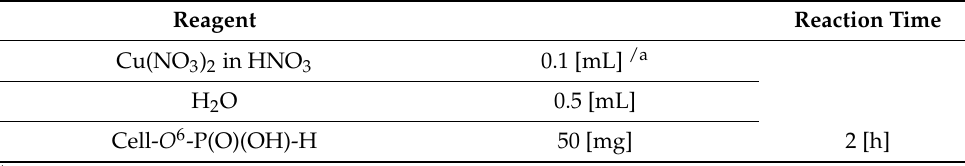
Table 2. Cellulose complexing reaction solution. Reagent Reaction Time Cu(NO 3 ) 2 in HNO 3 0.1 [mL] /a H 2 O 0.5 [mL] Cell- O 6 -P(O)(OH)-H 50 [mg] 2